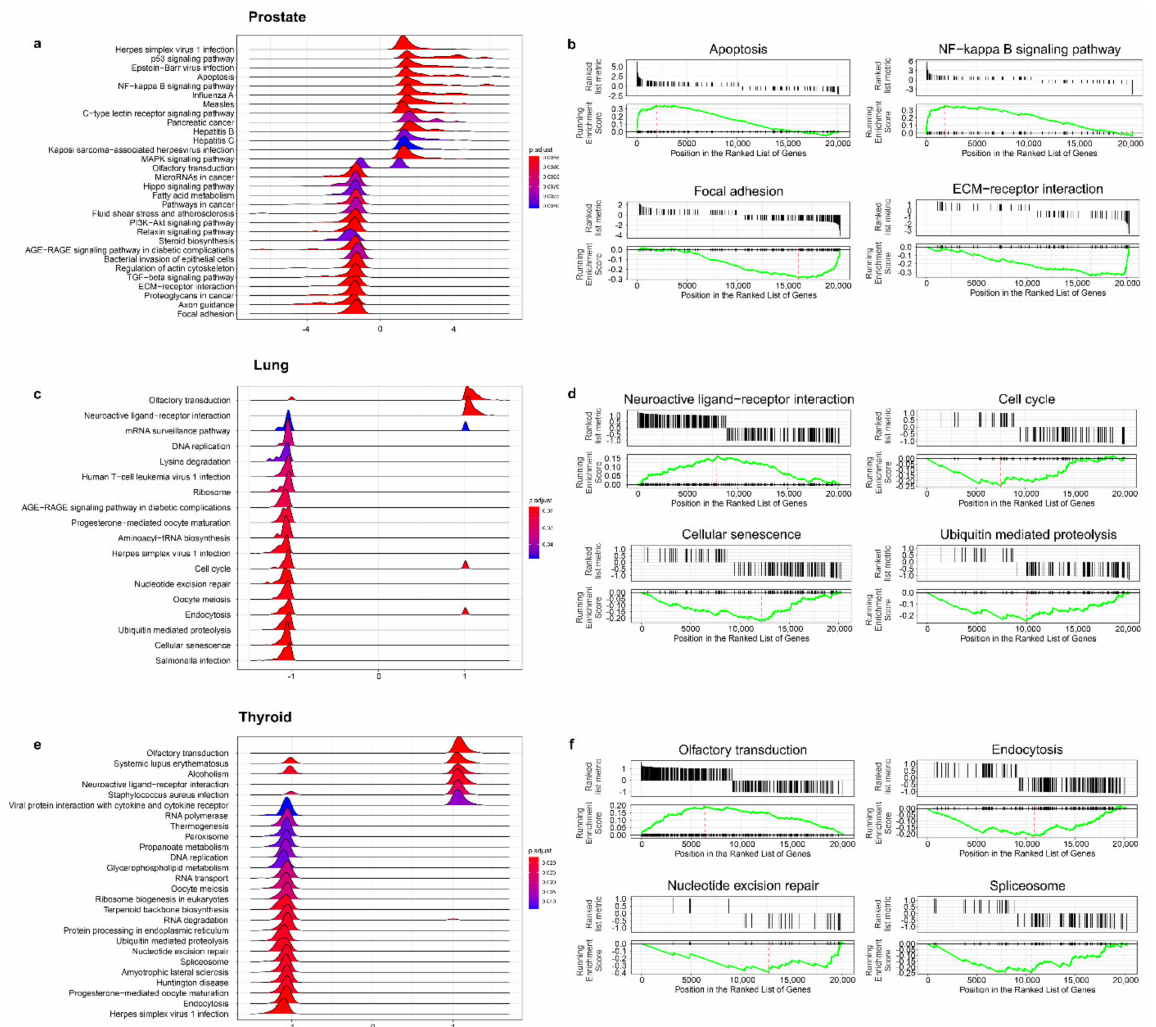
Figure 6. Results of gene set enrichment analysis (GSEA) based on gene expression measured in cells irradiated in prostate and peripheral organ locations. ( a , c , e ) show ridgeline plots with expression distribution for pathways differentially enriched between samples. The plot displays only the distribution of core enriched genes; ( b , d , f ) show the GSEA enrichment plots of selected gene sets. The peak of the green plot marks the enrichment score (ES) of a process. This analysis was based on the expression of all of the measured genes, both differentially expressed and non- differentially